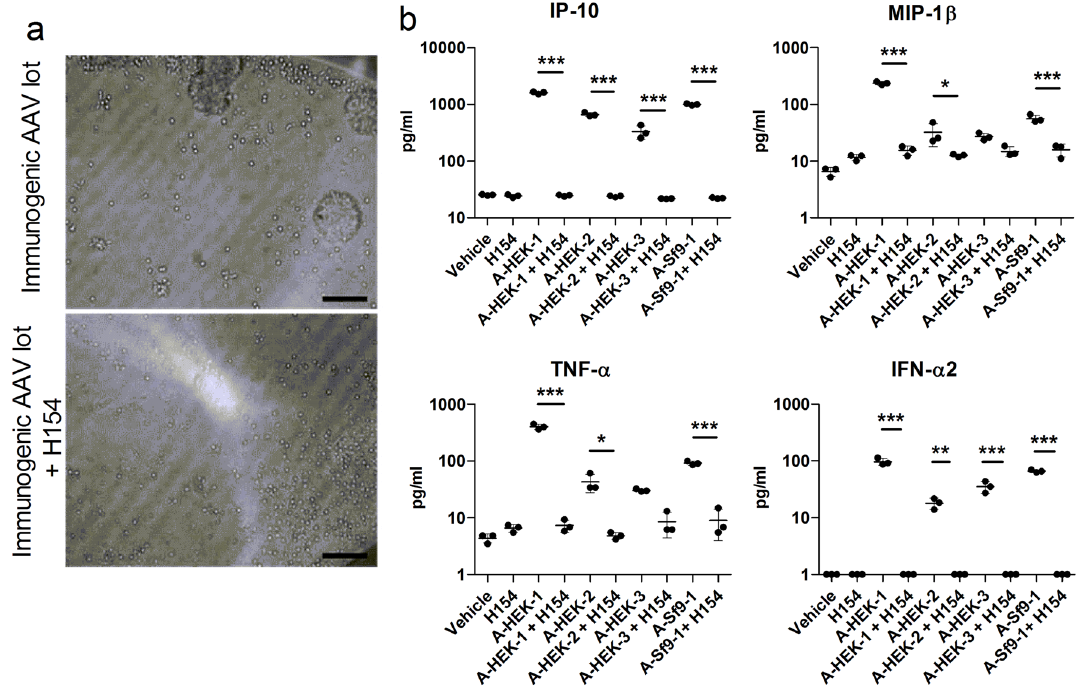
Figure 3. Recognition of “immunogenic” AAV8-CMV-eGFP vector lots by pDCs is TLR9 dependent. Human pDCs were treated with the TLR9 antagonist H154 (50 μM) followed by stimulation with “immunogenic” AAV8 vector lots (MOI: 1:1 × 10 6 vg) for 18 h. ( a ) Representative bright field images of purified pDCs treated with “immunogenic” AAV vector lots ( upper image ) or “immunogenic” AAV vector lots and H154 ( lower image ). Scale bar is 100 μm. ( b ) Cytokine release of IP-10, MIP-1β, TNF-α and IFN-α2 by stimulated pDCs. Since